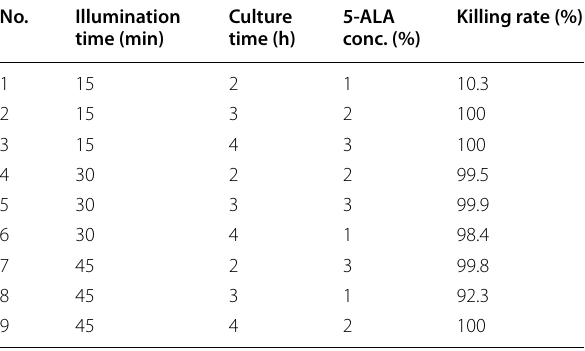
Table 3 Taguchi L9 experiment design for optimization of 5‑ALA aPDT against the pathogen of Proteus hauseri No.